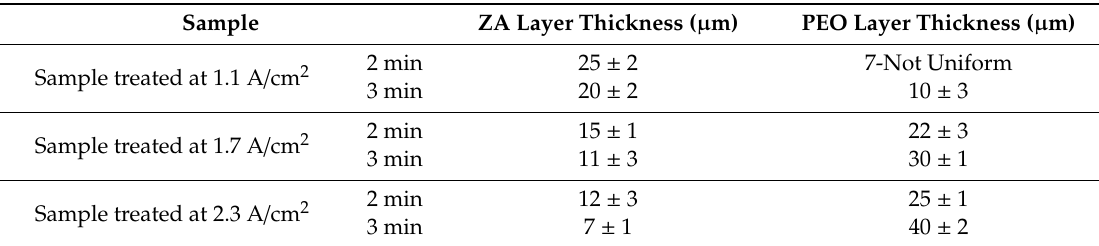
Table 1. Thickness of ZA and PEO layers of the di ff erent samples. Data coming from three di ff erent measurements.